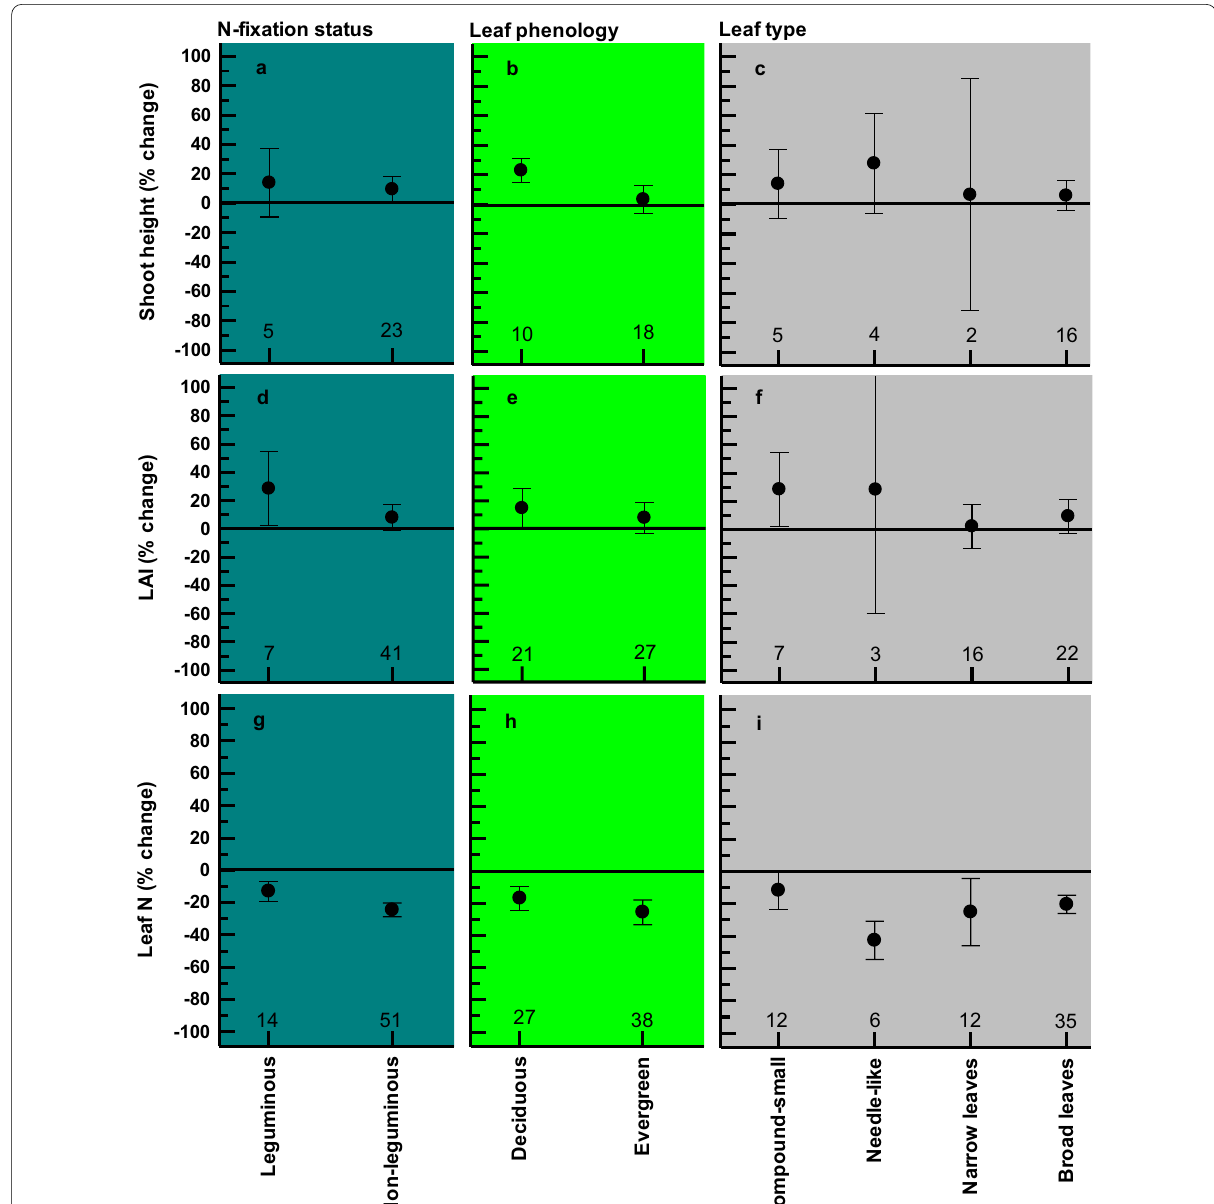
Fig. 7 Percentage change ( 95% CI) in shoot height, LAI and leaf N of woody plants with different N-fixation ability ( a , d and g ), leaf phenology ± ( b , e and h ) and leaf types ( c , f and i ) grown at eCO 2 . The whiskers denote 95% CI and the circles denote mean percentage change. The numbers above the major ticks of the x -axis denote number of observations. Key to leaf types: Compound-small Needle-like needle-like =